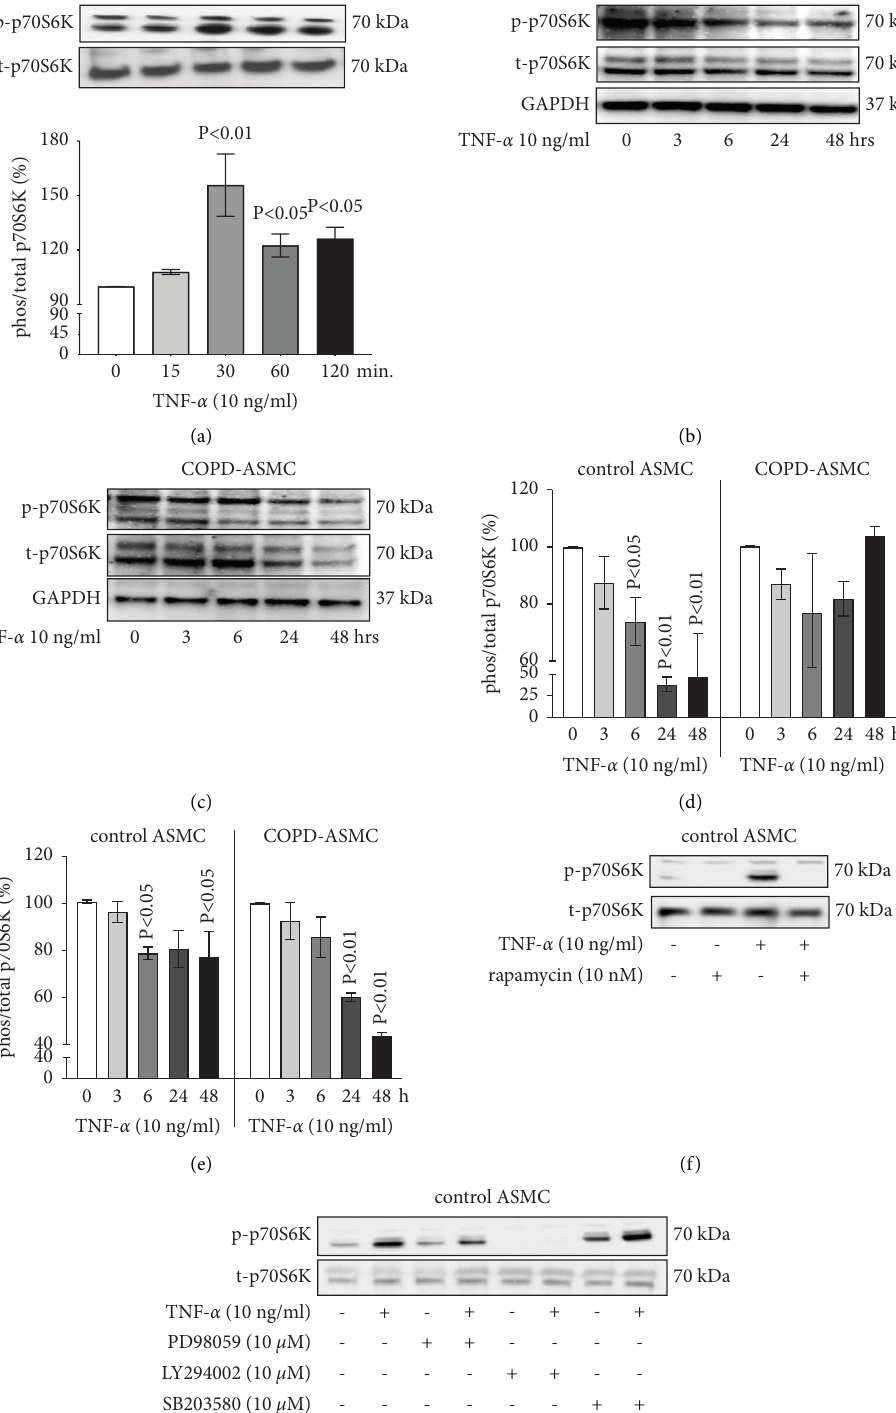
Figure 6: Te efect of TNF- α on mTOR signaling pathway. (a) Western blots of TNF- α -induced short-term p70S6K phosphorylation (120min.) in healthy nonsmokers ( n � 3) and subsequent image analysis. Bars show the ratio of phosphorylated (p-) to total (t)-p70S6K as percentage of time point 0. (b) Western blots of TNF- α -stimulated long-term (48 hours) phosphorylation of (p)-p70S6K in ASMC of healthy nonsmokers (control, n � 3). (c) Western blots of TNF- α -induced long-term p70S6K phosphorylation in COPD-ASMC ( n � 3) over 48 hours. (d) Image analysis of Western blots is presented in Figures 6(b) and 6(c). Bars compare the ratio of phosphorylation (p)-p70S6K to total (t-) p70S6K. (e) Image analysis of Western blots is presented in Figures 6(b) and 6(c). Bars show the ratio of t70S6K to GAPDH as percentage of time point 0. (f and g) Representative Western blots of TNF- α -induced p70S6K phosphorylation in ASMC of healthy nonsmokers (control) in the presence of diferent signaling pathway inhibitors (Rapamycin, PD98059, LY294002, and SB203580) at 24 hours. Similar results were obtained in three additional experiments. All P values were calculated by comparison to untreated